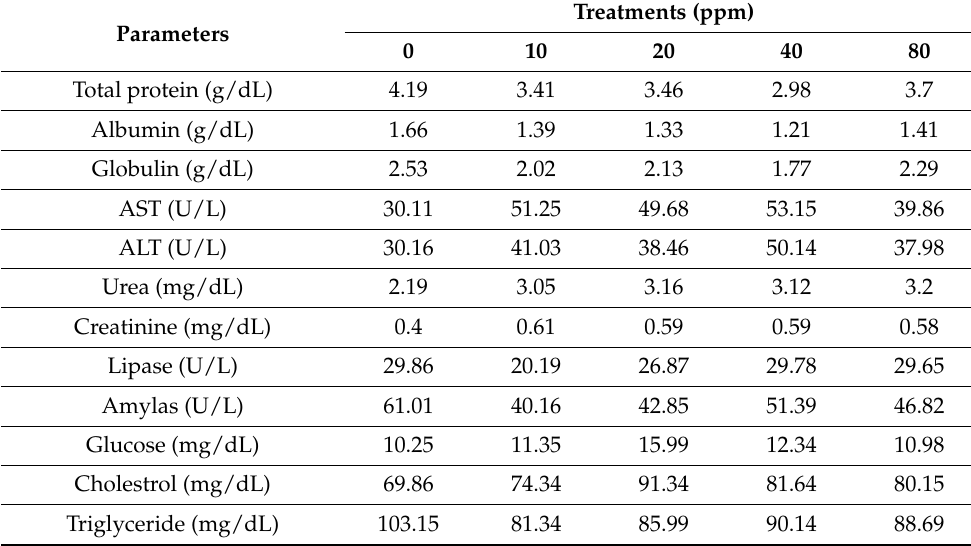
Table 9. Serum biochemical measurements of the Nile tilapia , O. niloticus exposed to different concen- trations of biosynthesized Hi